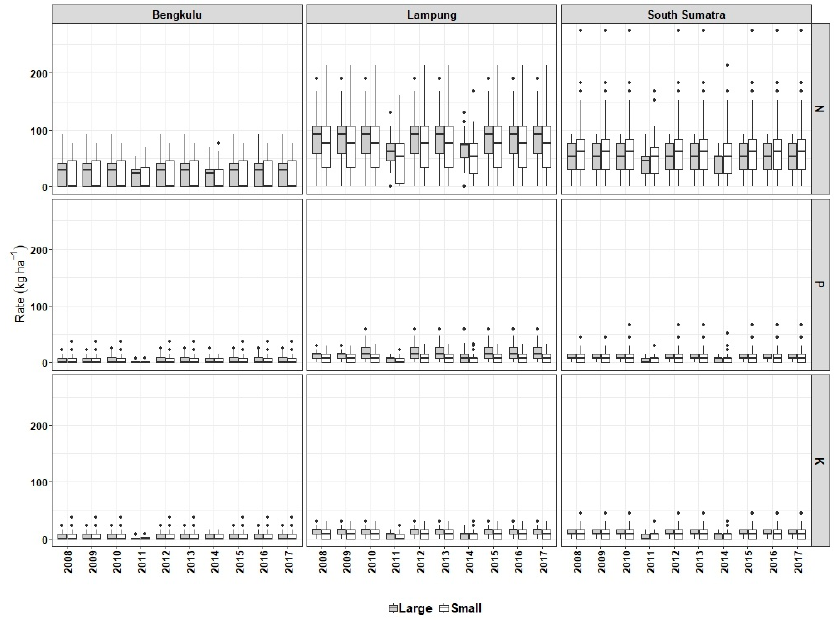
Figure 3. Year-to-year variations of nutrient rates in large- and small-scale Robusta coffee farms for each of the study provinces in Indonesia during the 2008–2017 period. The rates of nitrogen (N), phosphate (P 2 O 5 , referred to as P) and potassium (K 2 O, referred to as K) were calculated based of the nutrient contents of each of the chemical fertilizers recorded (see Tables 2 and 3). In the boxplot, upper and lower borders of the box represent the 3 rd and 1 st quartiles, respectively. The line within the box represents the median value. Bars extend to the minimum and maximum values. Outliers are represented by black circles. Small-scale farms have area ≤ 1 ha; large-scale farms have area >1 ha.